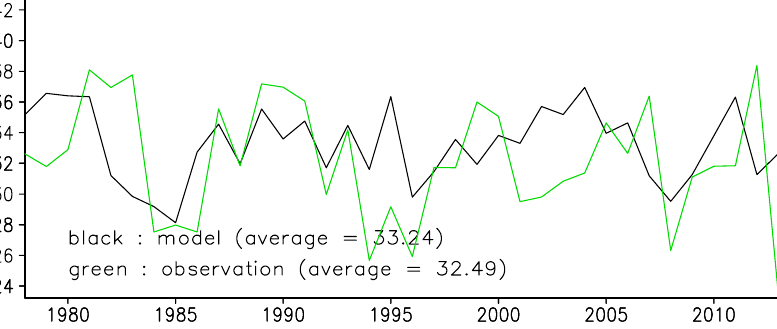
Variability of the net Kuroshio transport. We next examined causes of the net Kuroshio transport variation by focusing on the influence of WSC variations over the North Pacific in the CTRL run. In this study, we used the annual-mean WSC to take both cold- and warm-season atmospheric forcings into account. Lag-correlation